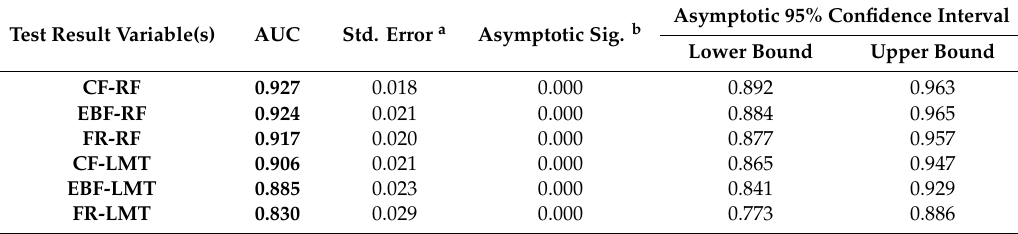
Table 2. The results of the receiver operating characteristic (ROC) area under the curve (AUC) of three GPM